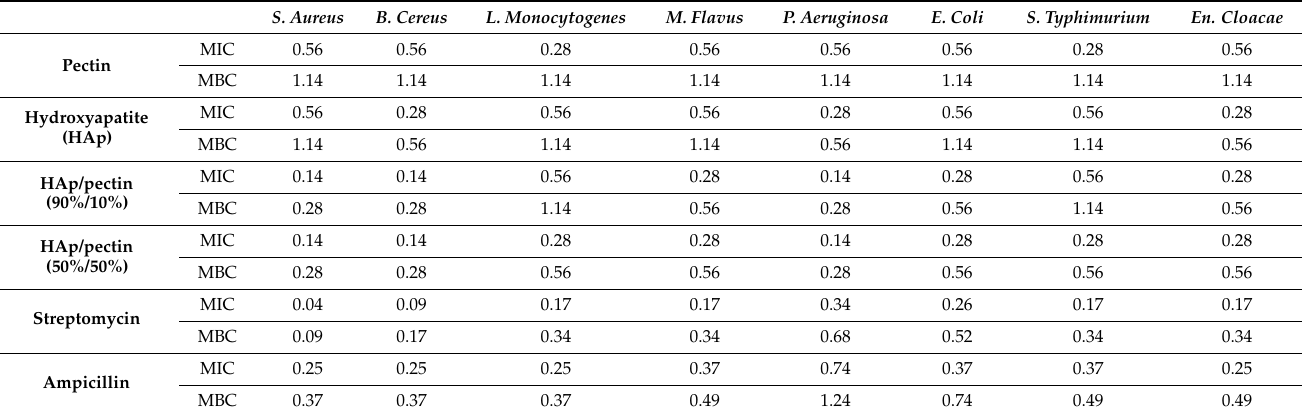
Table 3. Antibacterial activity of Opuntia ficus-indica pectin, hydroxyapatite, and composites (HAp/pectin) in mg/mL.